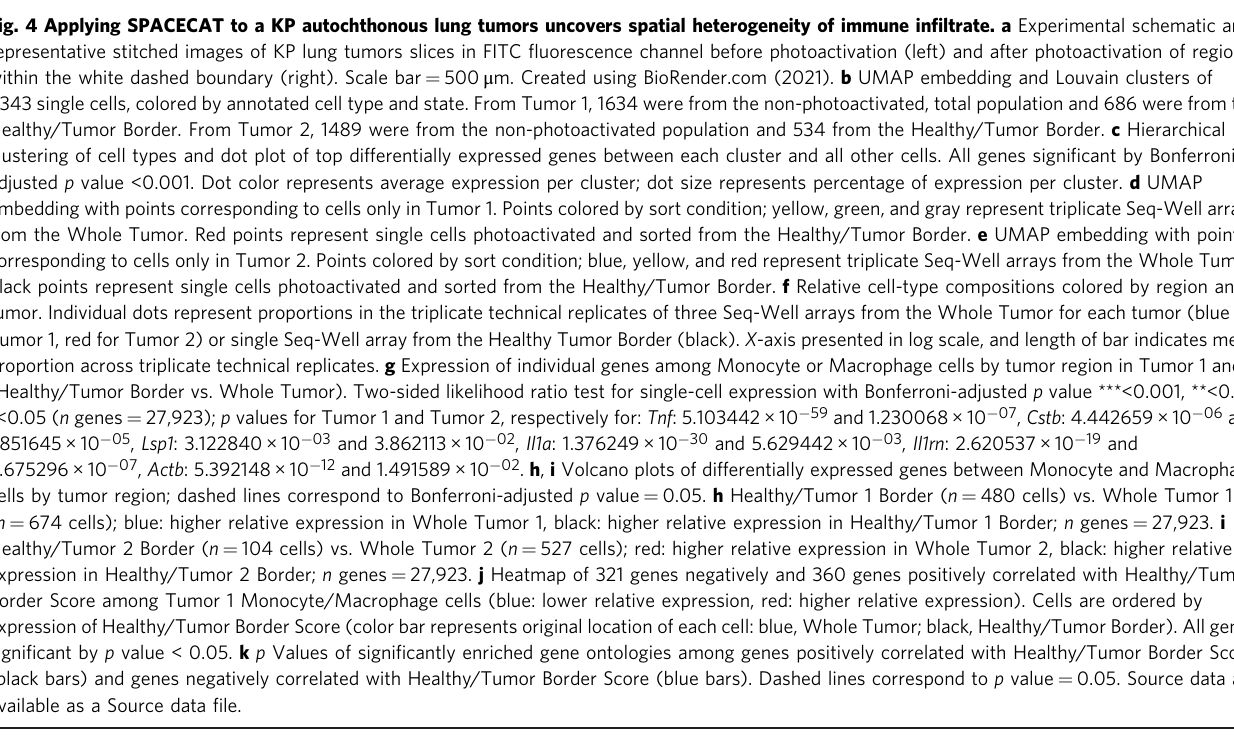
Fig. 4 Applying SPACECAT to a KP autochthonous lung tumors uncovers spatial heterogeneity of immune in fi ltrate. a Experimental schematic and representative stitched images of KP lung tumors slices in FITC fl uorescence channel before photoactivation (left) and after photoactivation of regions within the white dashed boundary (right). Scale bar = 500 μ m. Created using BioRender.com (2021). b UMAP embedding and Louvain clusters of 4343 single cells, colored by annotated cell type and state. From Tumor 1, 1634 were from the non-photoactivated, total population and 686 were from the Healthy/Tumor Border. From Tumor 2, 1489 were from the non-photoactivated population and 534 from the Healthy/Tumor Border. c Hierarchical clustering of cell types and dot plot of top differentially expressed genes between each cluster and all other cells. All genes signi fi cant by Bonferroni- adjusted p value <0.001. Dot color represents average expression per cluster; dot size represents percentage of expression per cluster. d UMAP embedding with points corresponding to cells only in Tumor 1. Points colored by sort condition; yellow, green, and gray represent triplicate Seq-Well arrays from the Whole Tumor. Red points represent single cells photoactivated and sorted from the Healthy/Tumor Border. e UMAP embedding with points corresponding to cells only in Tumor 2. Points colored by sort condition; blue, yellow, and red represent triplicate Seq-Well arrays from the Whole Tumor. Black points represent single cells photoactivated and sorted from the Healthy/Tumor Border. f Relative cell-type compositions colored by region and tumor. Individual dots represent proportions in the triplicate technical replicates of three Seq-Well arrays from the Whole Tumor for each tumor (blue for Tumor 1, red for Tumor 2) or single Seq-Well array from the Healthy Tumor Border (black). X -axis presented in log scale, and length of bar indicates mean proportion across triplicate technical replicates. g Expression of individual genes among Monocyte or Macrophage cells by tumor region in Tumor 1 and 2 (Healthy/Tumor Border vs. Whole Tumor). Two-sided likelihood ratio test for single-cell expression with Bonferroni-adjusted p value ***<0.001, **<0.01, *<0.05 ( n genes = 27,923); p values for Tumor 1 and Tumor 2, respectively for: Tnf : 5.103442 × 10 − 59 and 1.230068× 10 − 07 , Cstb : 4.442659 × 10 − 06 and 1.851645 × 10 − 05 , Lsp1 : 3.122840 × 10 − 03 and 3.862113 × 10 − 02 , Il1a : 1.376249 × 10 − 30 and 5.629442× 10 − 03 , Il1rn : 2.620537 × 10 − 19 and 9.675296 × 10 − 07 , Actb : 5.392148× 10 − 12 and 1.491589 × 10 − 02 . h , i Volcano plots of differentially expressed genes between Monocyte and Macrophage cells by tumor region; dashed lines correspond to Bonferroni-adjusted p value = 0.05. h Healthy/Tumor 1 Border ( n = 480 cells) vs. Whole Tumor 1 ( n = 674 cells); blue: higher relative expression in Whole Tumor 1, black: higher relative expression in Healthy/Tumor 1 Border; n genes = 27,923. i Healthy/Tumor 2 Border ( n = 104 cells) vs. Whole Tumor 2 ( n = 527 cells); red: higher relative expression in Whole Tumor 2, black: higher relative expression in Healthy/Tumor 2 Border; n genes = 27,923. j Heatmap of 321 genes negatively and 360 genes positively correlated with Healthy/Tumor Border Score among Tumor 1 Monocyte/Macrophage cells (blue: lower relative expression, red: higher relative expression). Cells are ordered by expression of Healthy/Tumor Border Score (color bar represents original location of each cell: blue, Whole Tumor; black, Healthy/Tumor Border). All genes signi fi cant by p value < 0.05. k p Values of signi fi cantly enriched gene ontologies among genes positively correlated with Healthy/Tumor Border Score (black bars) and genes negatively correlated with Healthy/Tumor Border Score (blue bars). Dashed lines correspond to p value = 0.05. Source data are available as a Source data fi